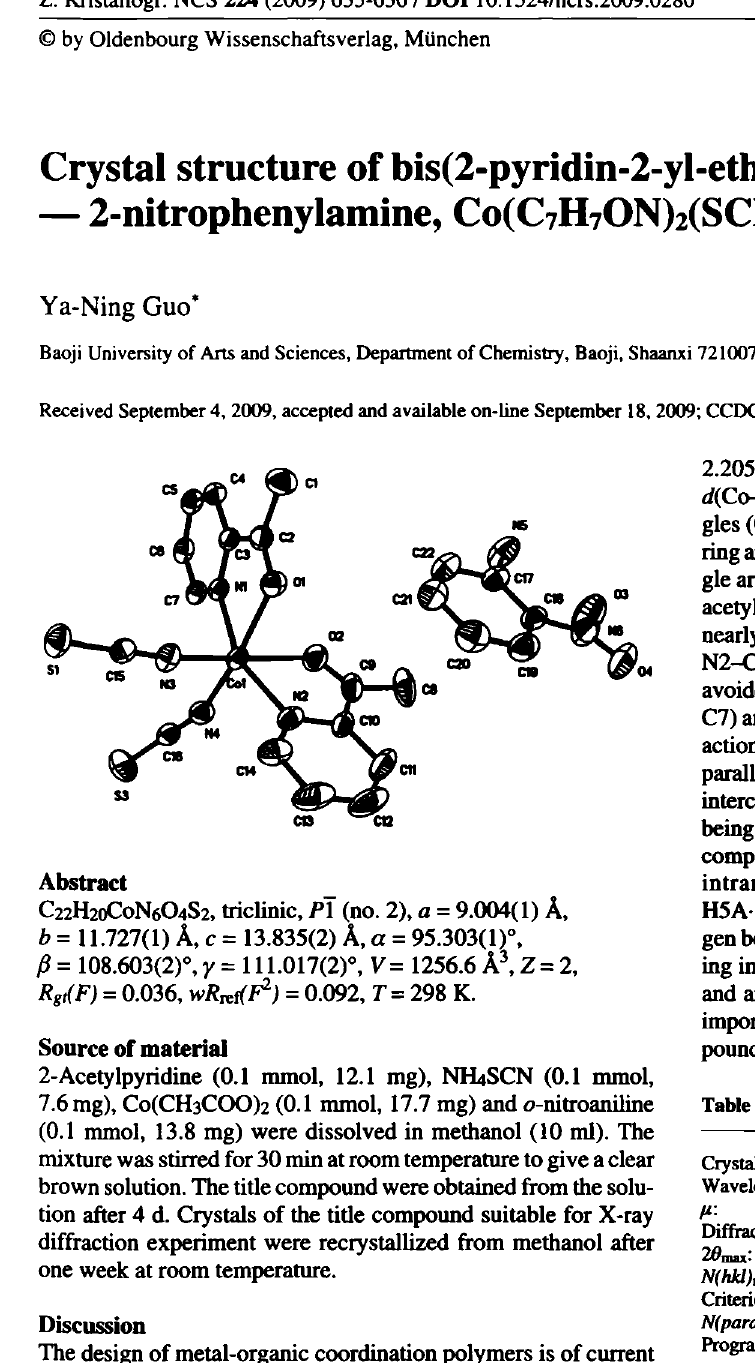
Table 2. Atomic coordinates and displacement parameters (in Â 2